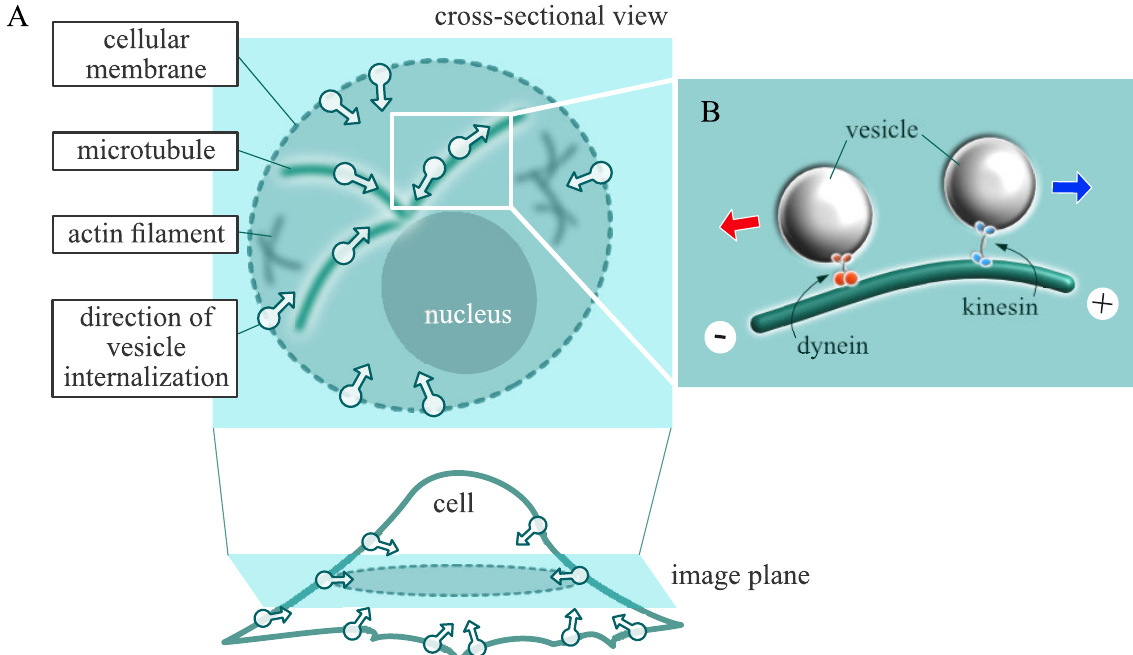
Figure 1. Concept of vesicle transport in a living cell. ( A ) Diagram of intracellular transport of quantum dot-labeled vesicle from cell cross-sectional view. Vesicles (White-colored circles with arrows) are internalized from the cellular membrane and then transported as they interact with cytoskeletal network, such as actin filament and microtubule. ( B ) Two different types of motor proteins, dynein and kinesin, for microtubule-based transport: Kinesins deliver vesicles in outward direction from the cell center, which is toward the plus end of the microtubule, while dyneins carry vesicles toward the microtubule minus end, which is approximately inward direction with respect to the cell